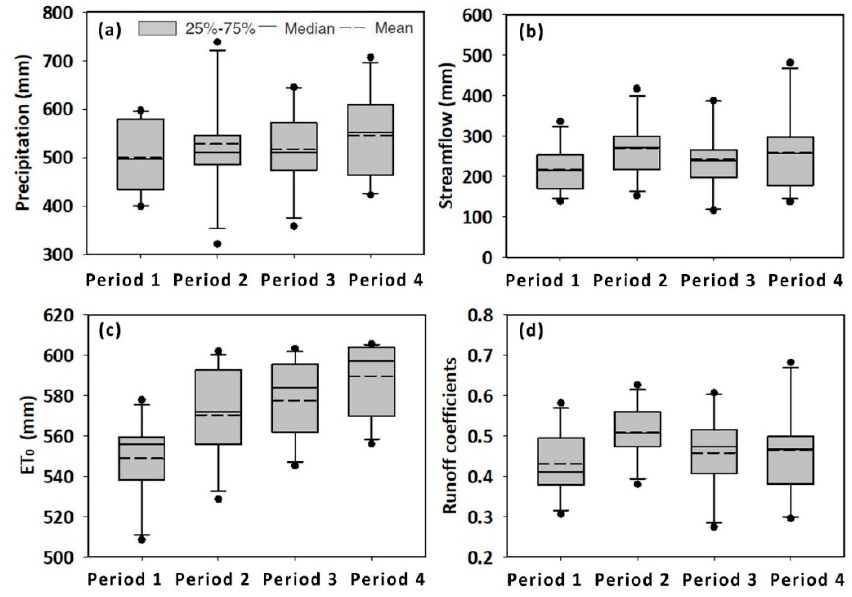
Figure 5. ( a ) The precipitation in four periods; ( b ) The streamflow in four periods; ( c ) The ET 0 in four periods; ( d ) The runoff coefficients in four periods. Period 1 = 1972–1982, Period 2 = 1984–1994, Period 3 = 1995–2005, Period 4 = 2006–2016.